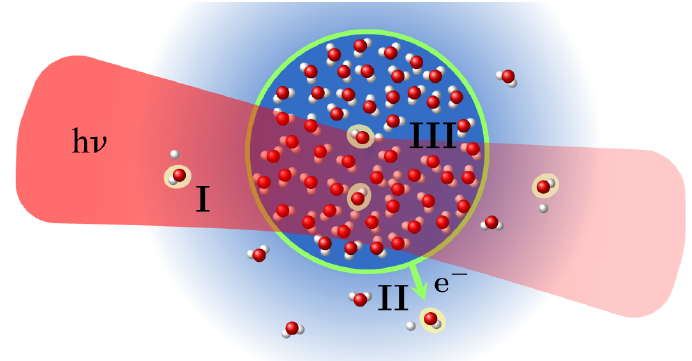
Figure 9. Illustration of a transversal section through a liquid microjet and indication of three processes (labelled I, II, and III) observed by photon spectroscopy after X-ray irradiation. For details see text and Ref. [45]. Reprinted with permission from The Journal of Physical Chemistry 121, 2326. Copyright 2017 American Chemical